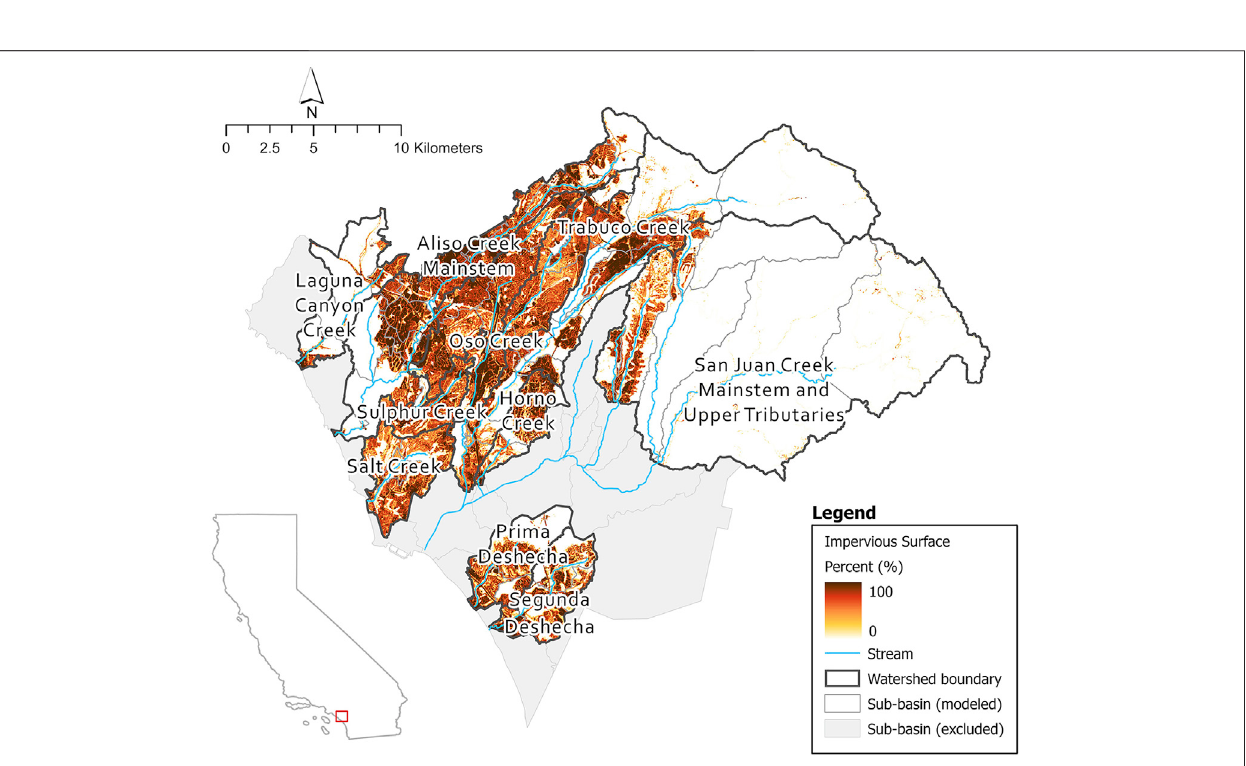
Frontiers in Environmental Science |